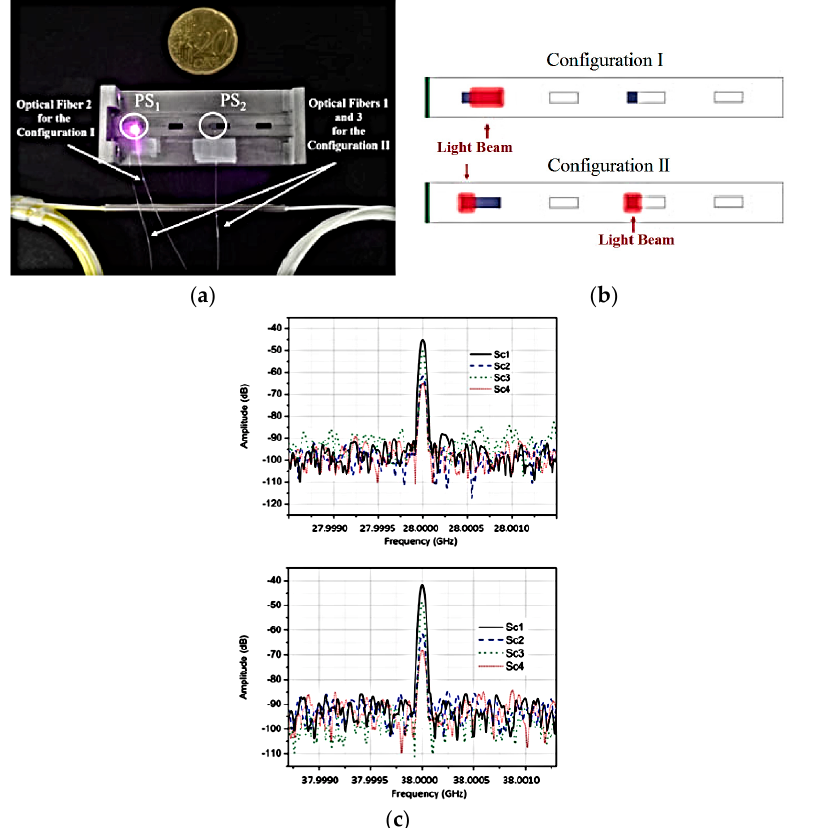
Figure 6. ( a ) Measurement setup of the fabricated prototype ( b ) measured/simulated results (redrawn from